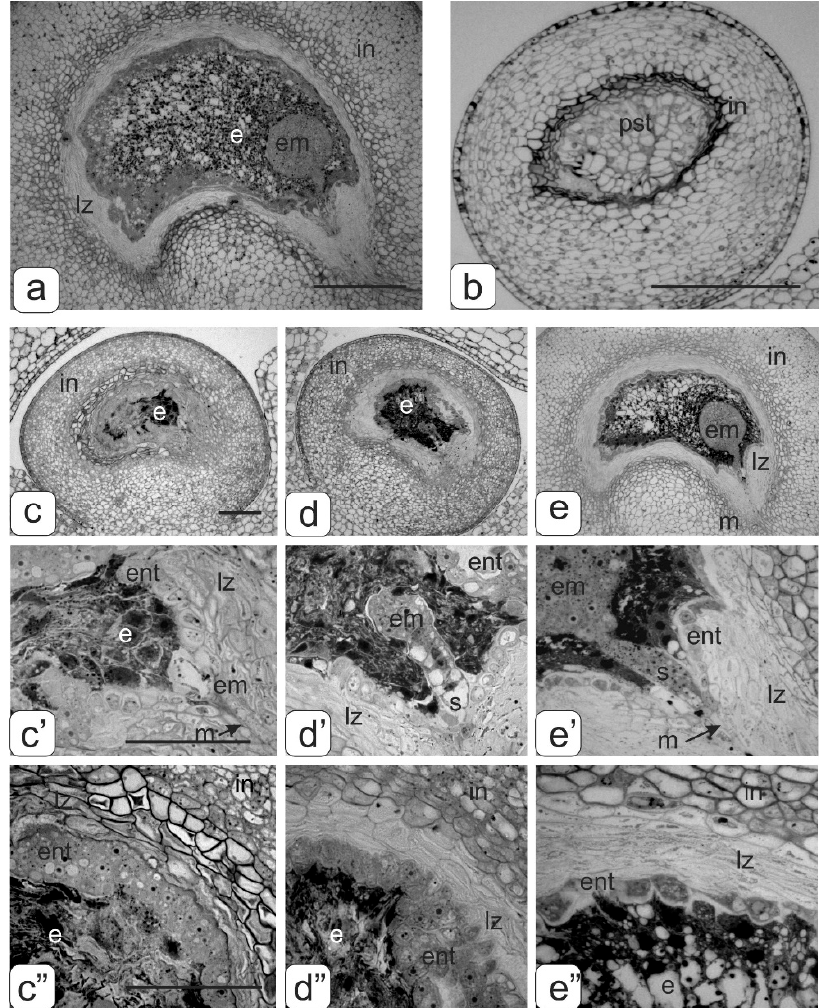
Figure 10. Disturbances of ovule development in transgenic tomato plants. ( a )—globular stage development of the embryo in the control tomato plant; ( b )—ovule with a pseudo-embryo in parthenocarpic fruits of transgenic tomato plants with abnormalities; proembryo stage ( c , c’ ), stage of the early globular embryo ( d , d’ ) and stage of late globular embryo ( e , e’ ) in transgenic tomato plants without phenotypic anomalies; structure endothelium tissue on stage of the early embryo ( c” , d” ) and stage of late globular embryo ( e” ). Bar: a–e—100 μ m; c, c’–e, e’—50 μ m.